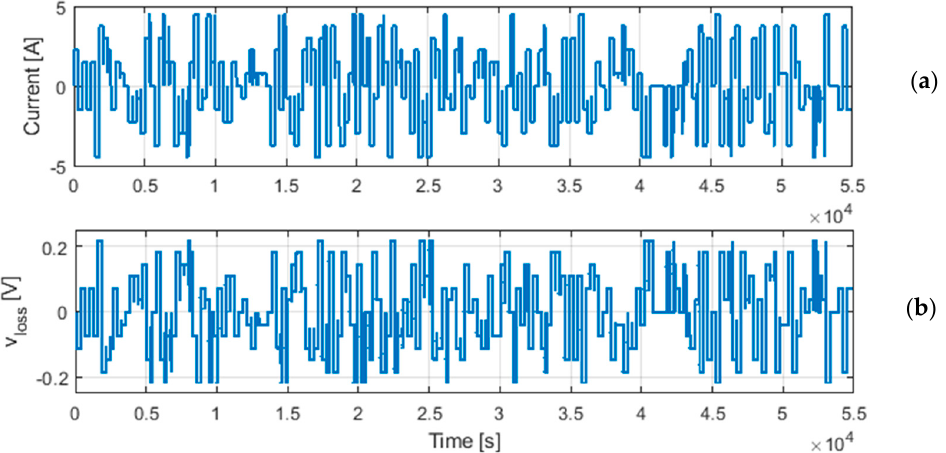
Figure 9. Voltage loses v loss obtained for an applied dynamic current profile. ( a ) dynamic current profile. ( b ) voltage losses.